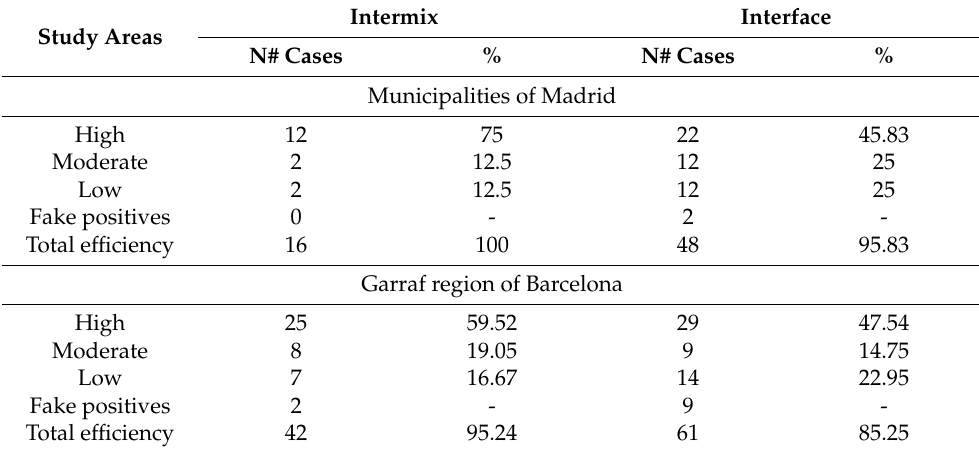
Table 3. Exposure results in intermix and interface identified by SIOSE 2014. Study